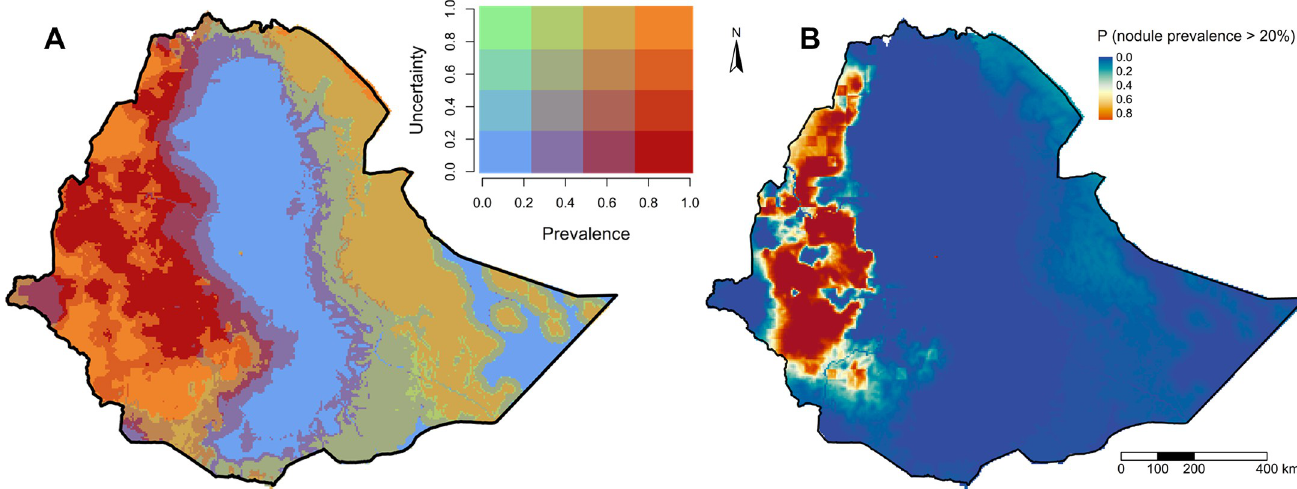
Fig 3. Uncertainty in the estimates of O . volvulus nodule prevalence from the model. (A) Exceedance threshold probability map that shows the posterior predictive probability that the nodule prevalence is greater than 20%. (B) Bivariate map that shows both prevalence and the uncertainty estimates rescaled from 0 to 1. The administrative borders are from the Global Administrative Areas (GADM) database (available at: https://gadm.org/maps.html).